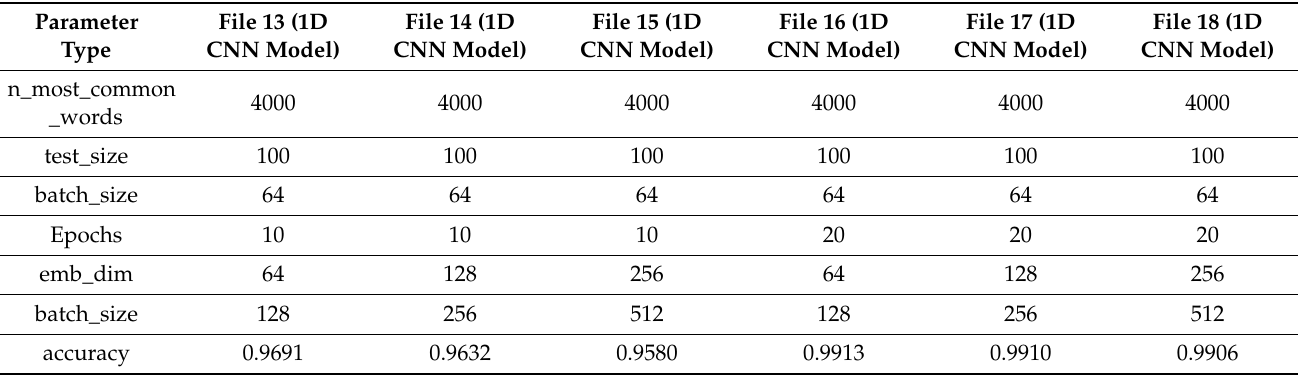
Table 6. Chatbot program test results (Files 13 to